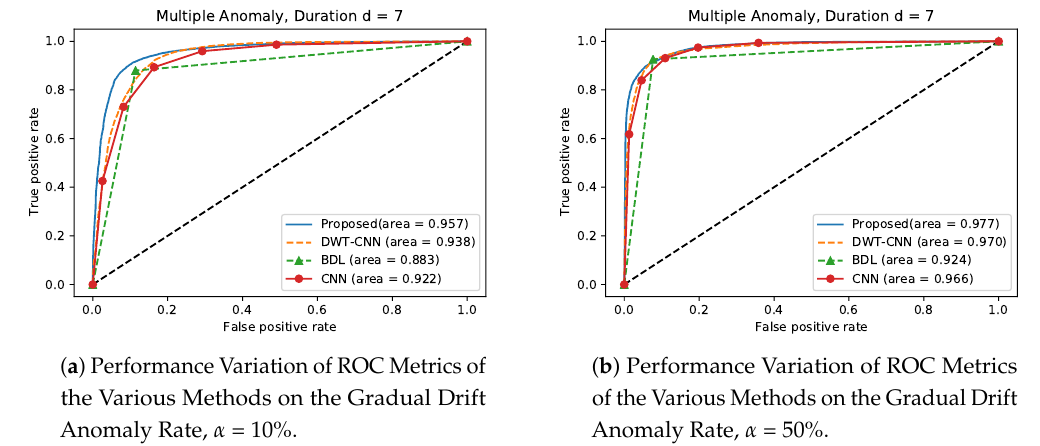
Figure 14. Performance Variation of the Various Methods trained on Instance Anomaly, on Gradual Drift Anomaly at α = 10% and α = 10%.